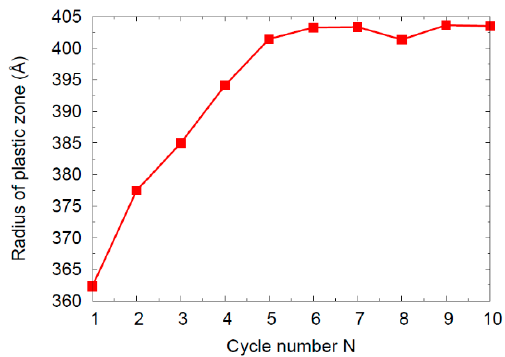
Figure 10. Dependence of the plastic-zone radius R pl during cyclic indentation on cycle number.